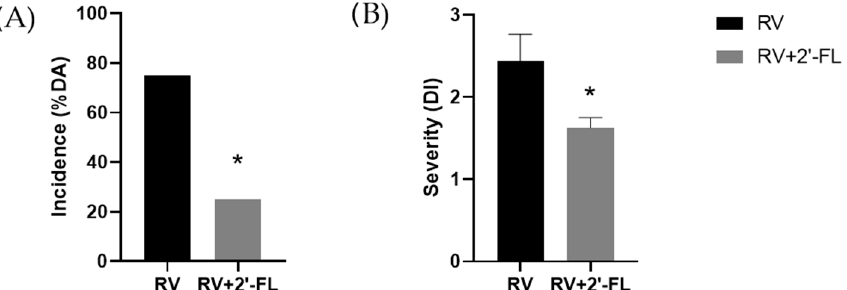
Figure 1. Preventive effect of 2 ′ -FL on the RV infection. ( A ) Incidence (%DA, Diarrheic Animals) and ( B ) Severity (DI, Diarrhoea Index) on day 8 of the selected animals of the array study ( n = 4, from three different litters). Results are expressed as unique values of % for incidence (derived from all animals each day) and as mean ± S.E.M. for severity. Statistical differences: * p < 0.05 compared to RV group by chi-square test and by MWU test, respectively.